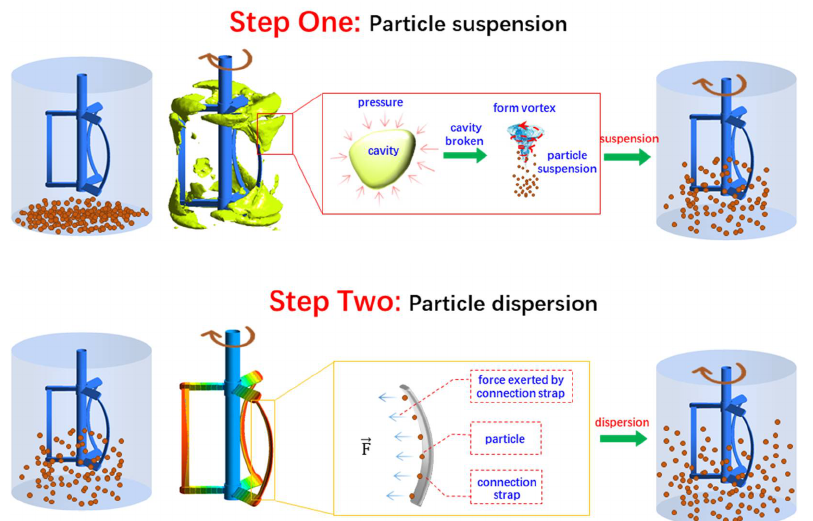
Figure 14. Deviation of axial ξ at different axial locations. (Solid loading: 30%; connection strap length: 1.2 Hs.)